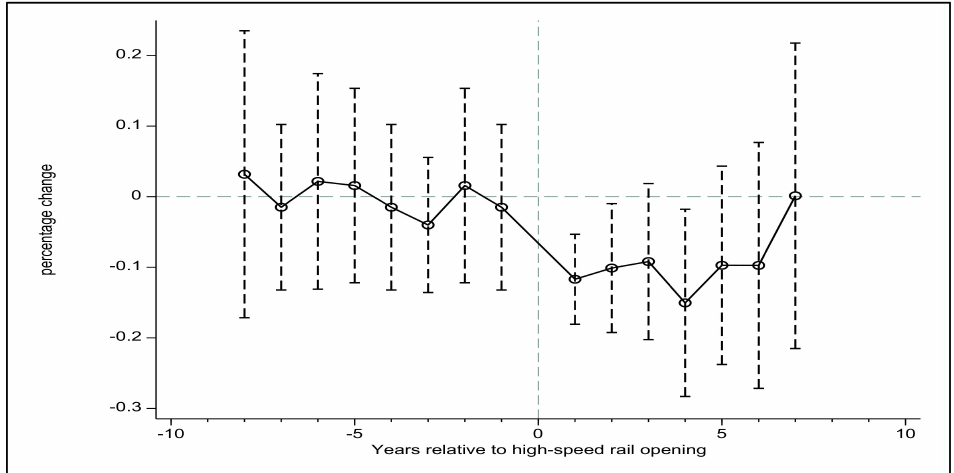
Figure 2. Parallel trend